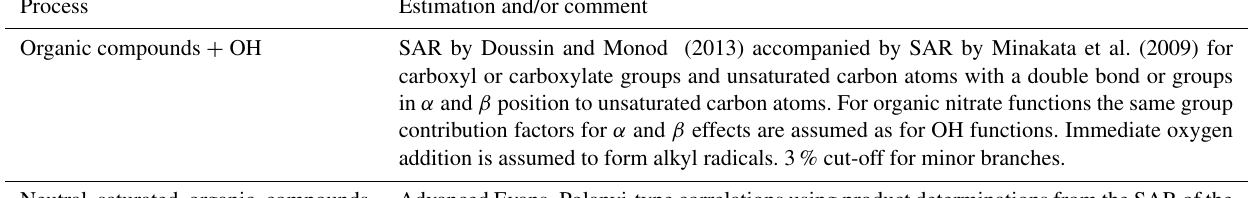
Table 2. Processes implemented in the final GECKO-A aqueous-phase protocol for mechanism auto-generation. Process Estimation and/or comment Organic compounds +